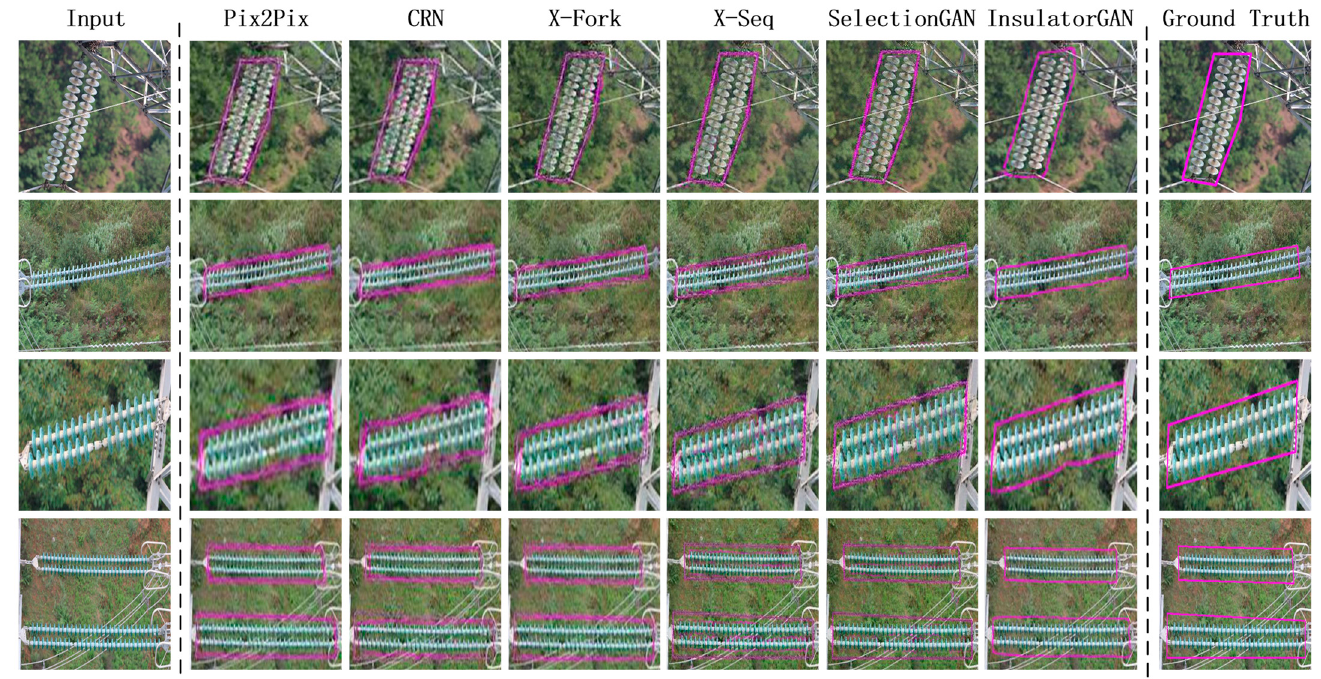
Figure 5. Test examples of each model on the InsuGenSet dataset.